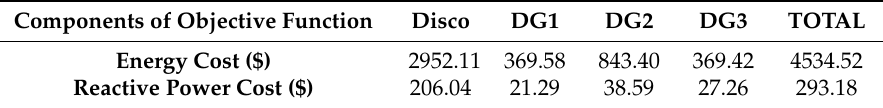
Table 4. Optimization results of the joint active/reactive power dispatch in Scenario 1. Components of Objective Function